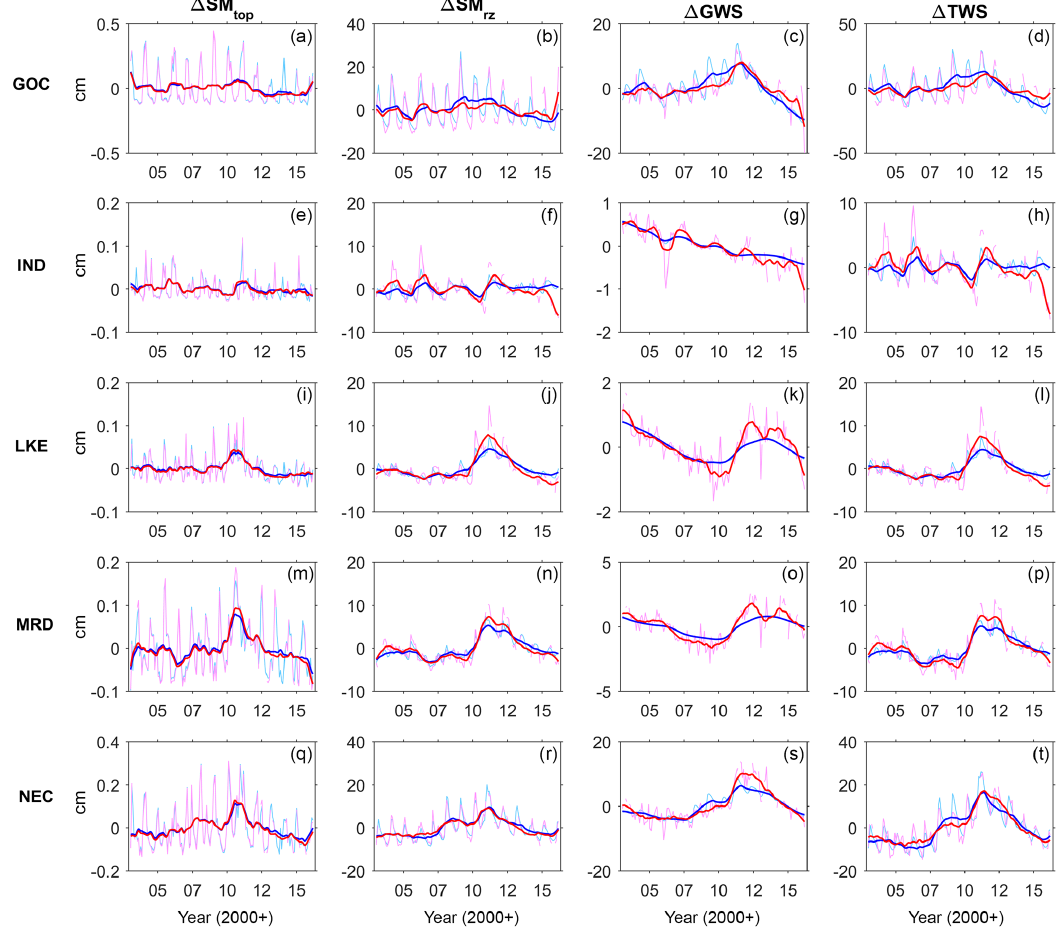
Figure 4. The monthly time series of (cid:49) SM top , (cid:49) SM rz , (cid:49) GWS, and (cid:49) TWS estimated from model (blue) and GC (red) solutions over the Gulf of Carpentaria (GOC), Indian Ocean (IND), Lake Eyre (LKE), Murray–Darling (MRD), and North East Coast (NEC). The deseasonal- ized time series is also